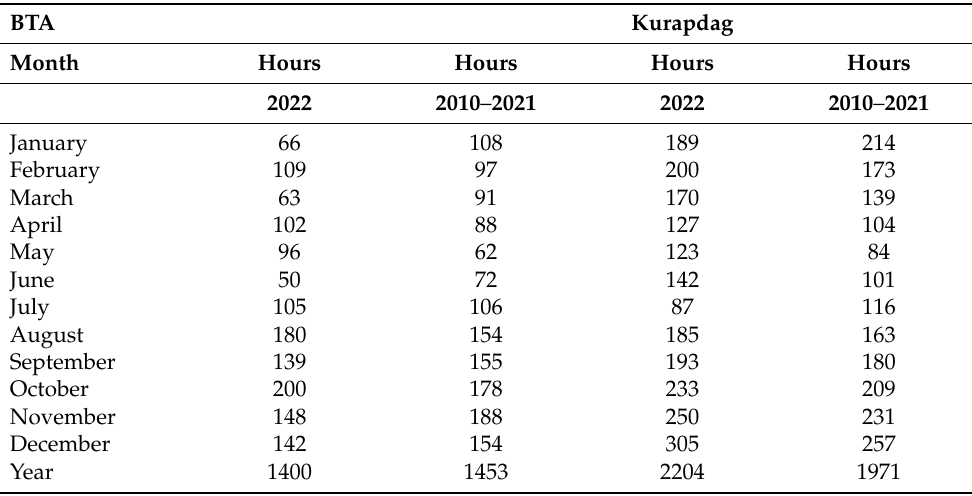
Table 6. Estimations of observing time at the BTA. The value in December 2022 is the forecast